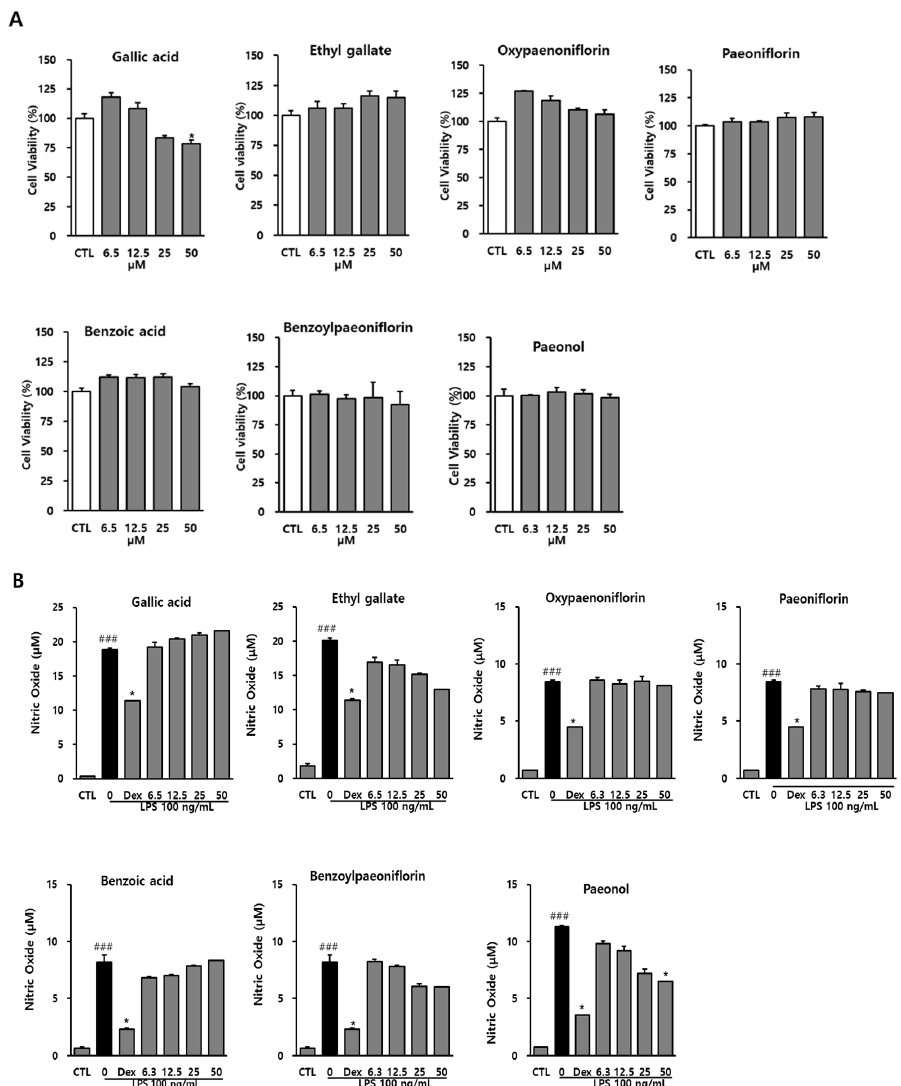
Figure 4. Effects of the MRC identified compounds on inhibition of nitric oxide (NO) production. RAW 264.7 cells were pretreated with various concentrations of seven compounds of MRC. ( A ) Comparison in cytotoxic effects of the seven compounds of MRC. ( B ) Comparison in